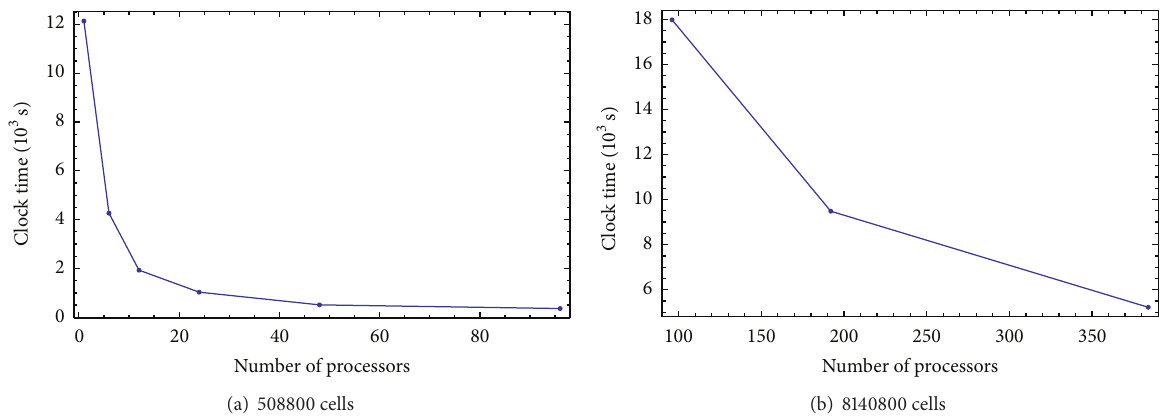
Figure 8: The clock time versus the number of